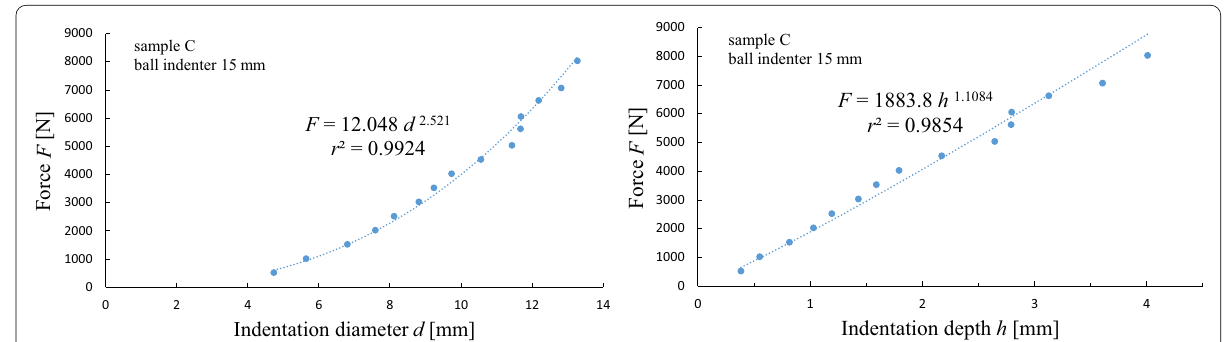
Fig. 5 Comparison of Meyer power law for the force dependence on the diameter of indentation (left chart) with the Brinell measure determining the force dependence on the depth of indentation (right chart). The data refer to indentations with a 15‑mm‑diameter ball on beech wood (sample